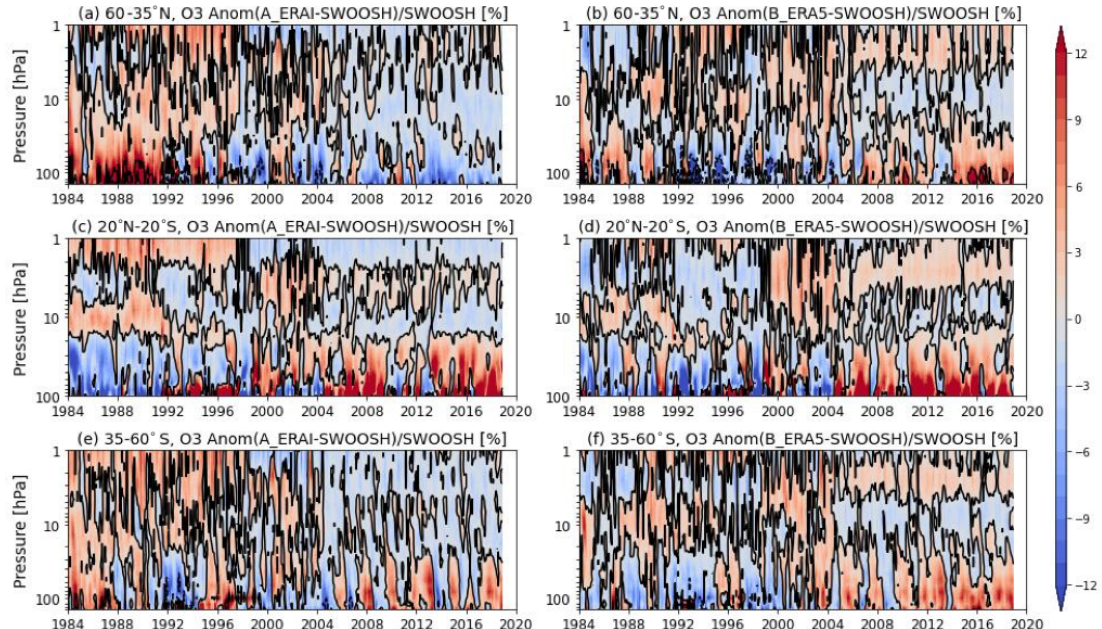
Figure 6. Pressure–time cross section of the relative differences (%) in ozone anomalies between model simulations A_ERAI, B_ERA5, and SWOOSH over 1984–2019 (August) for different latitude regions (a, b) 60–35 ◦ N, (c, d) 20 ◦ N–20 ◦ S, and (e, f) 35–60 ◦